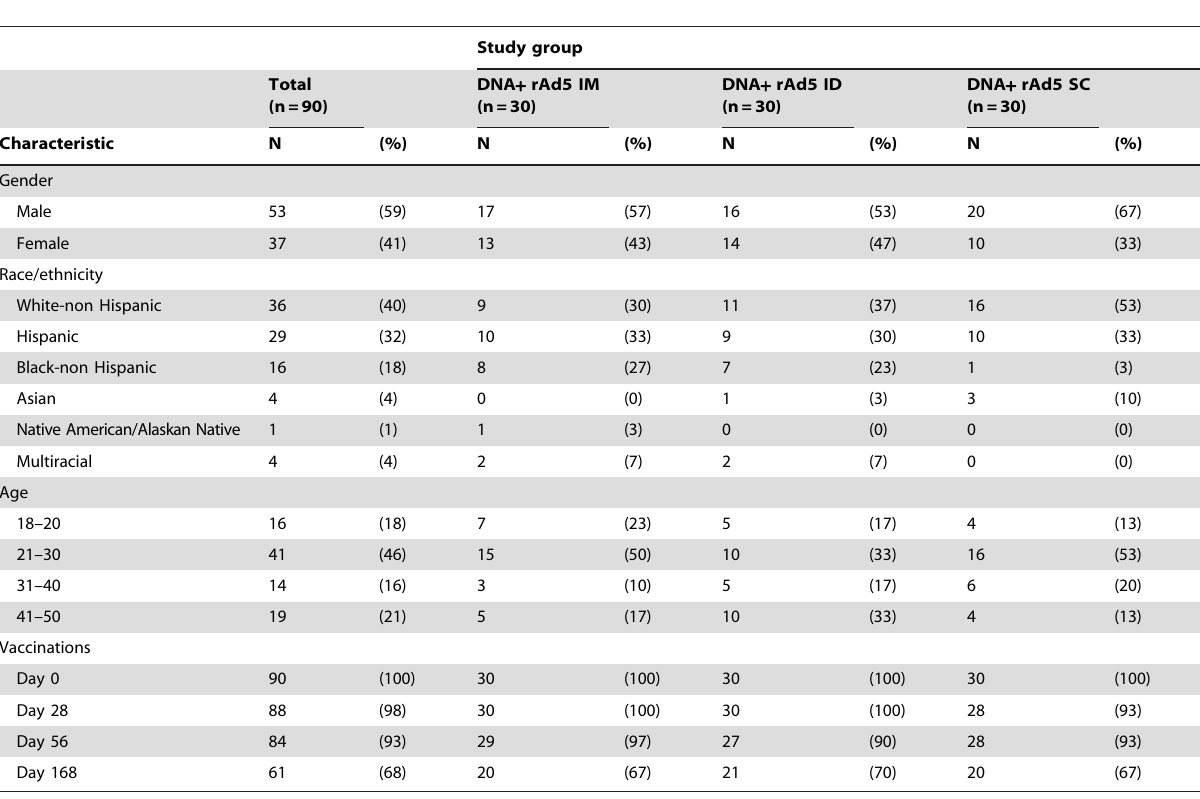
Table 1. Demographic characteristics and vaccination by study